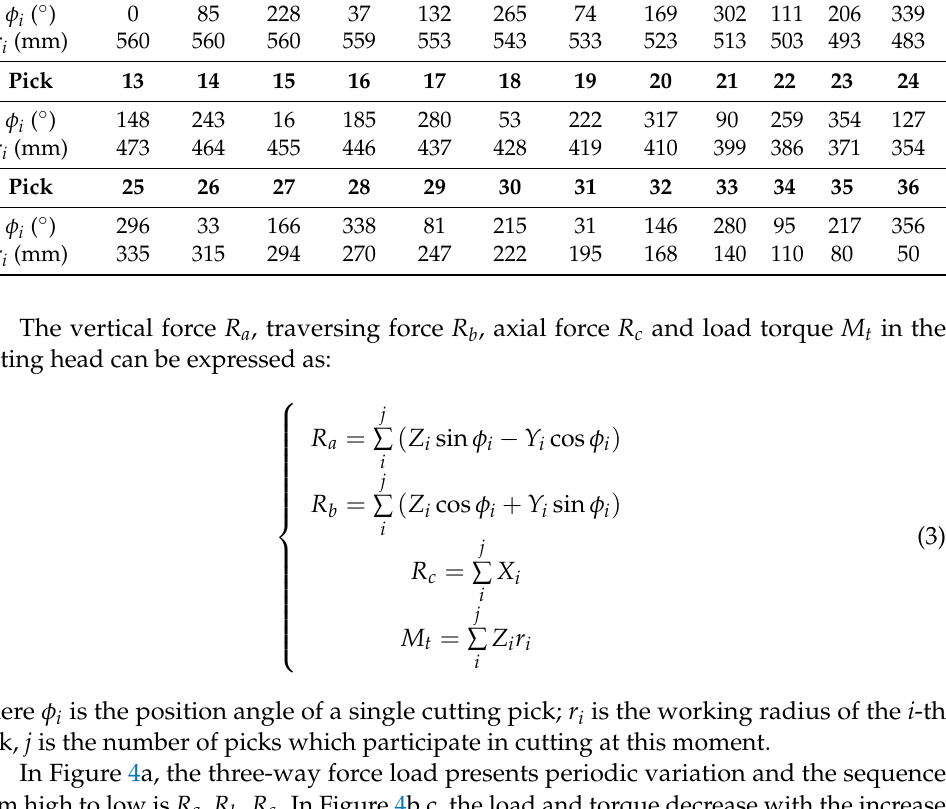
Table 1. The value of parameters in the load calculation formula.